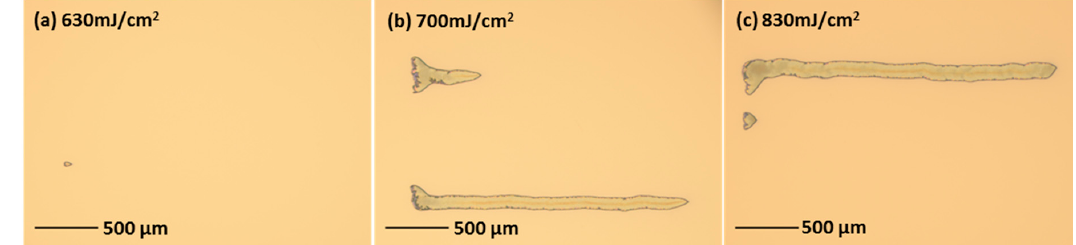
Figure 5. Typical surface damage morphologies of the Raster Scan for a tested MLD coating with laser fluence increasing from ( a – c ).